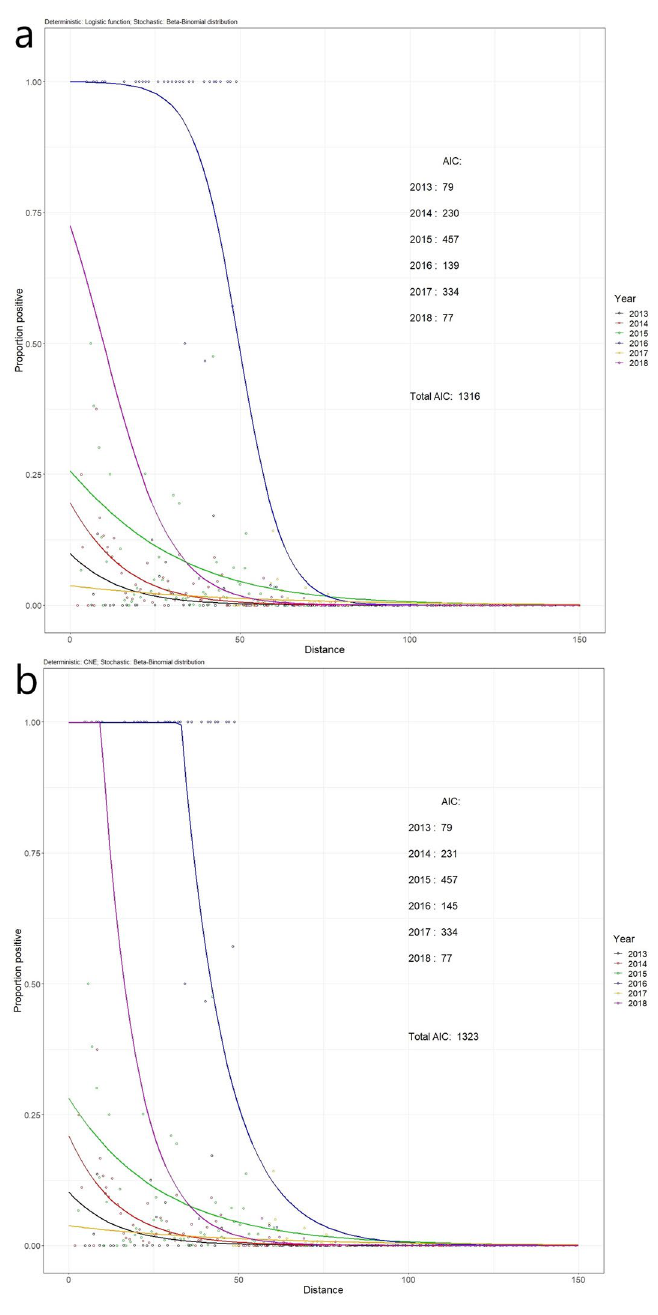
( a ) Logistic function; ( b ) CNE